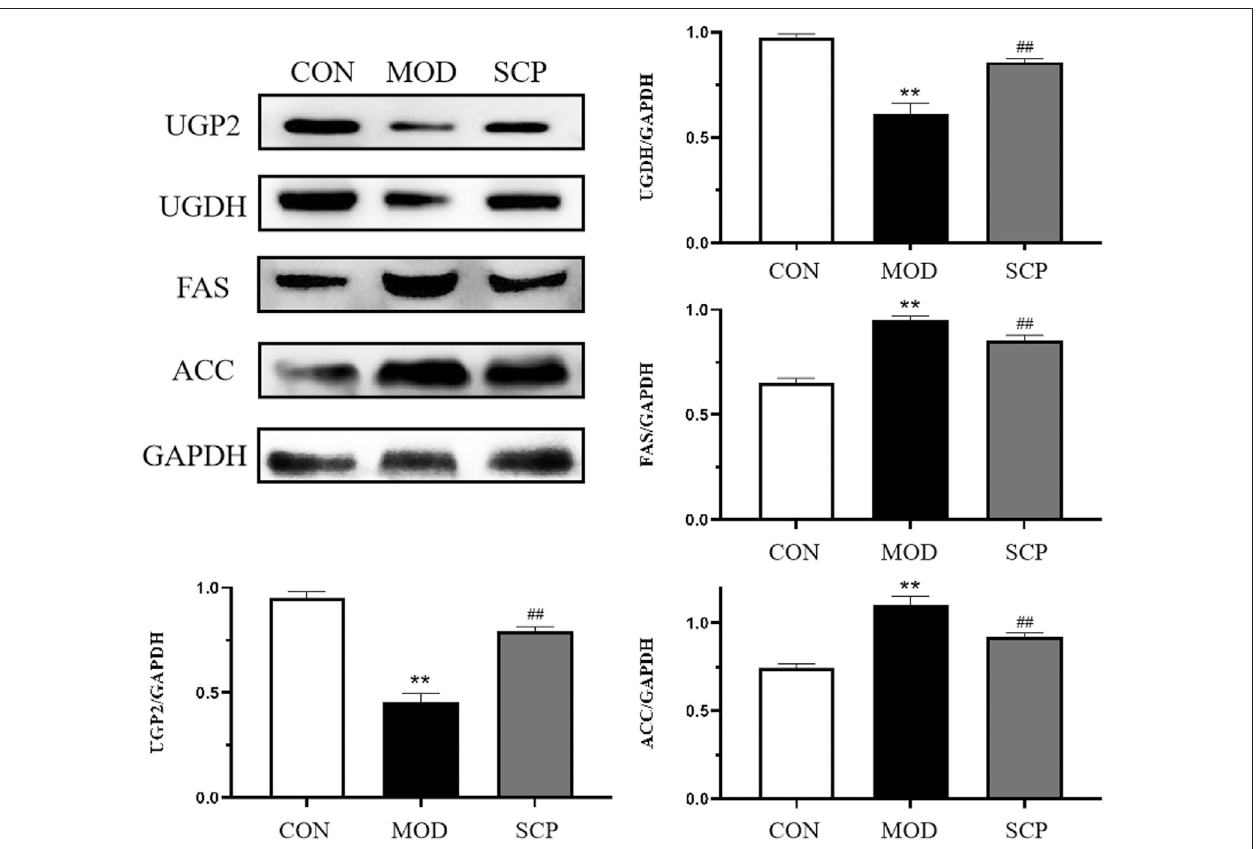
FIGURE 9 | Effects of SCP on the expression of UGP2, UGDH, FAS, ACC, and GAPDH proteins in the liver tissue. All the values were expressed as means ± standard deviation. Compared with the CON group, * p < 0.05, ** p < 0.01; compared with the MOD group, # p < 0.05, ## p < 0.01.